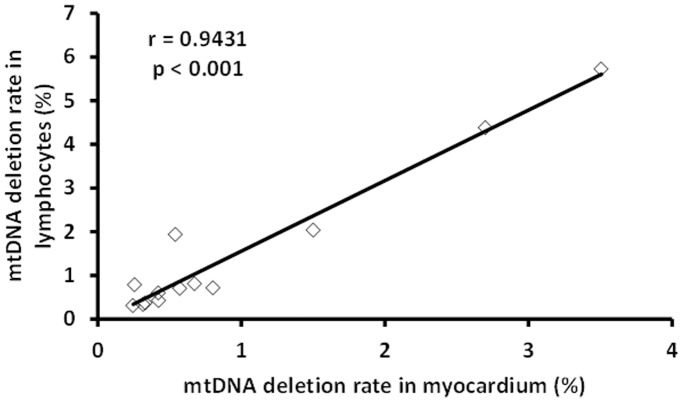
The correlation curve of summation mtDNA deletion rate between myocardium and lymphocytes in VMD patients.